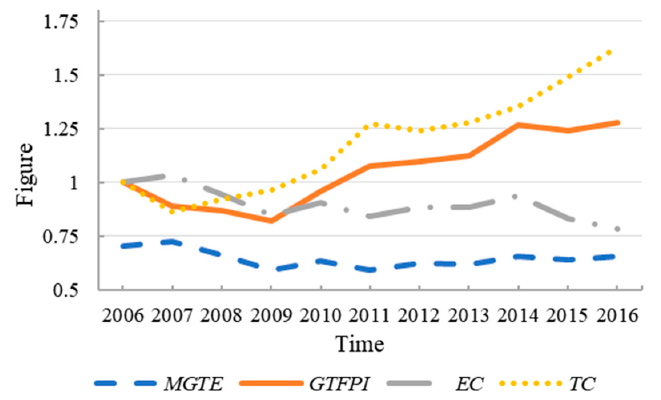
Figure 2. Changes in green efficiency of marine economy from 2006 to 2016.